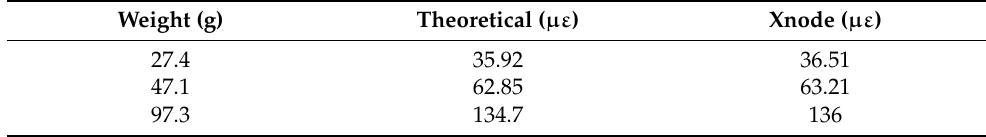
Table 2. Experimental results for static strain